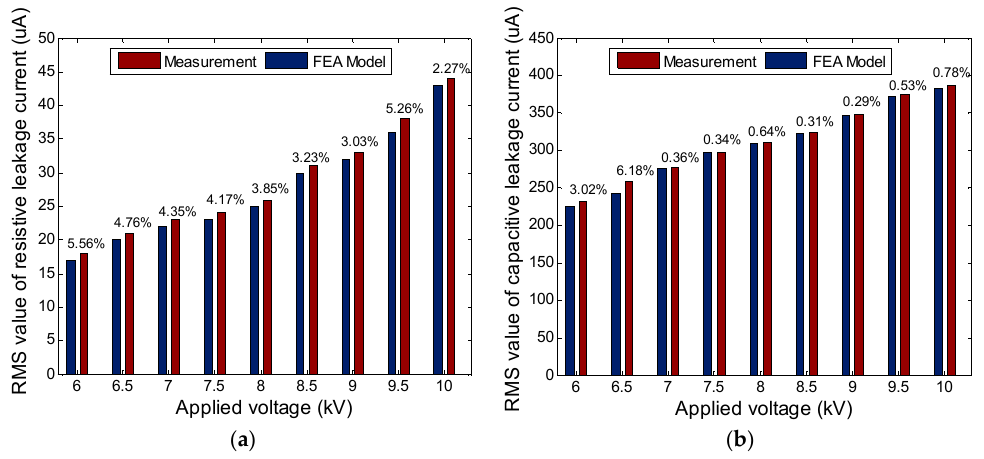
Figure 6. Comparison of RMS value of total leakage current between measurement and FEA model under different applied voltage amplitudes.